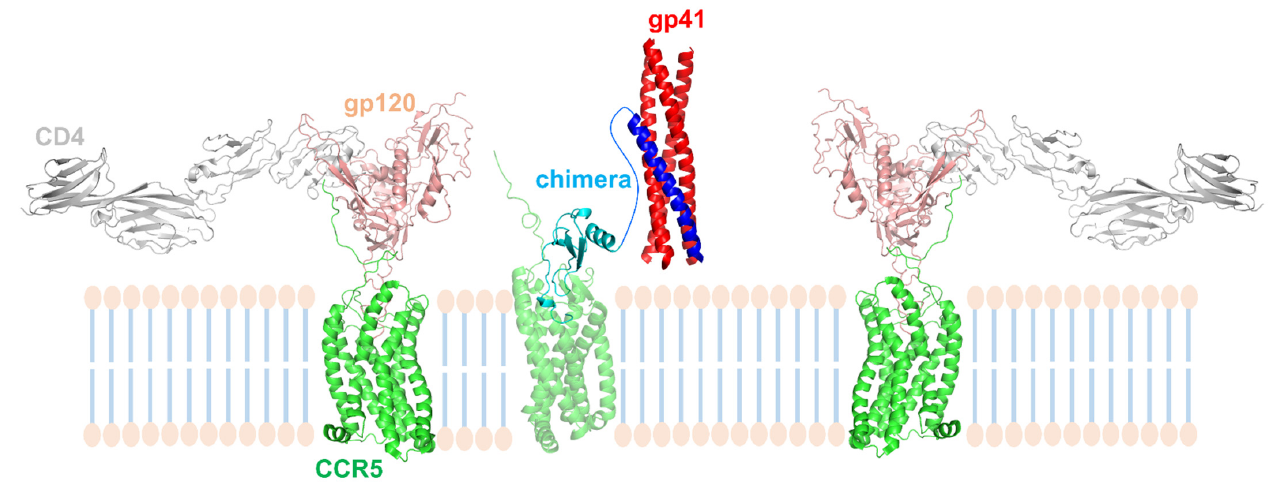
Figure 5. Model of the synergic inhibitory effect exerted by CCL5 5p12 5m-C37 on R5 tropic HIV-1 strains. Spare molecules of CCR5 escape inhibition by the CCL5 5p12 5m moiety of the chimera and allow CD4-bound gp120 to engage them, making space for gp41 to undergo the conformational changes leading to membrane fusion. The membrane fusion machinery of gp41 is readily blocked by the membrane proximity (provided by chimera-bound CCR5 molecules) of the C37 moiety of the chimera. Three-dimensional ribbon representation were generated by using PyMOL: CD4 (grey):gp120 (salmon):CCR5 (green) complexes (left and right) from PDB entry 6MET [4]; gp41 N-heptad repeat (red):C34 (blue) (arbitrarily represented here as C37) complex from PDB entry 6R2G [42]; CCR5 (transparent green):CCL5 5p12 5m (light blue) complex was modeled [11] upon PDB entry 5UIW [9]. The linker in the CCL5 5p12 5m-C37 chimera is arbitrarily shaped in blue. The cell membrane bilayer is schematized.